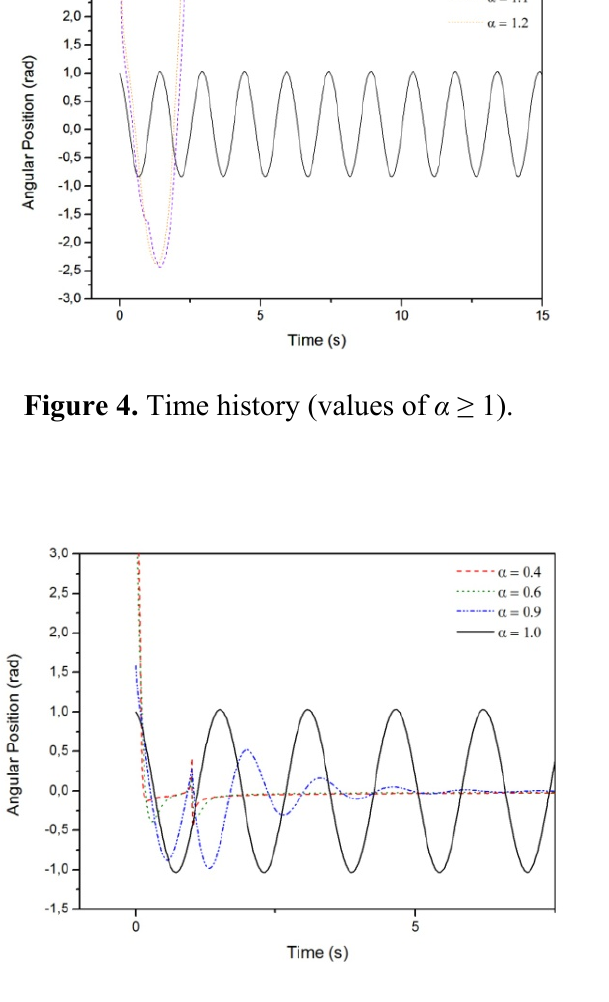
Figure 5. Time history (values of α ≤ 1).